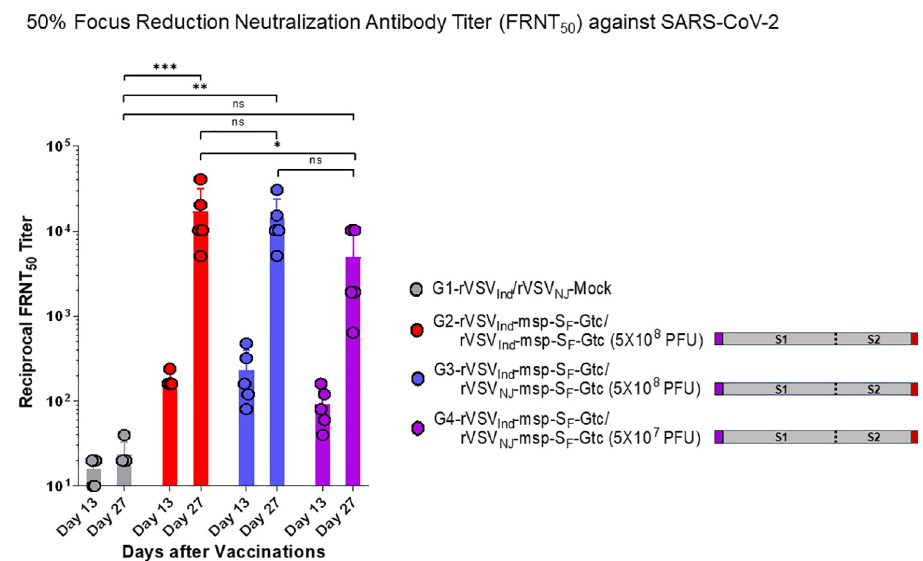
Fig 6. Prime-boost vaccination of hACE2 transgenic mice induces high levels of neutralizing antibodies against SARS-CoV-2. Six-week-old female hACE2 transgenic mice were prime vaccinated with rVSV Ind -msp-S F -Gtc and boost immunized with rVSV Ind -msp-S F -Gtc or rVSV NJ -msp-S F -Gtc two weeks after the prime-vaccination. Serum was collected on day 13, one day before the boost-vaccination and on day 27, two weeks after the boost-vaccination. SARS- CoV-2 neutralization was determined by FRNT 50 assay. Statistical significance was determined by two-way ANOVA with Tukey’s correction ( � , p < 0.05; �� , p < 0.005; ��� , p < 0.001; ns, not significant). The data were presented as means with error bars of standard deviation (n = 5 mice per group). Purple box: honeybee msp, red box: VSV Gtc. VSV-Mock denotes VSV vector alone without any gene